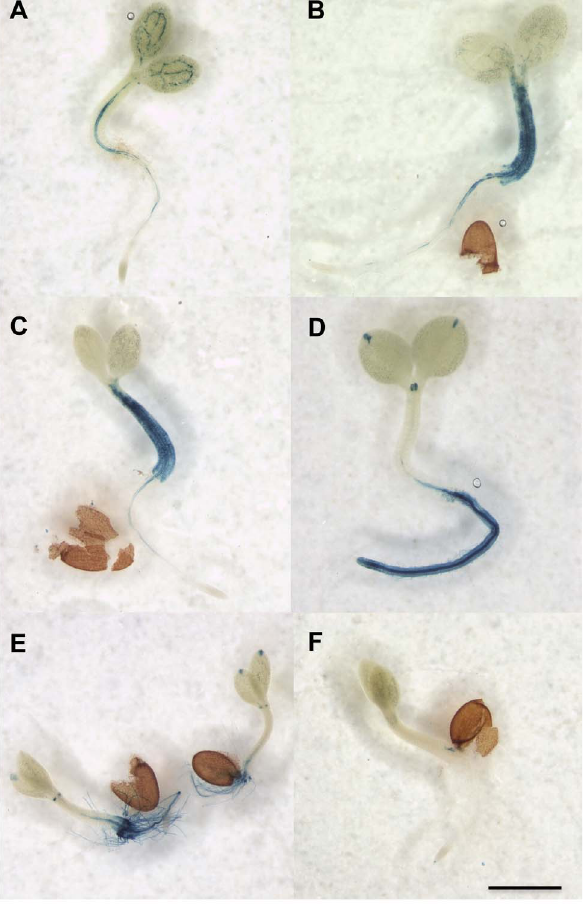
Figure 6. Transcriptional fusion analysis of Arabidopsis DEFL promoter constructs in T4 transgenic seedlings expressing pSCR: LhG4 / OP :GUS. Histochemical staining for GUS activity in 1- week-old seedlings transformed with promoter constructs of Arabi- dopsis DEFLs . A, At1g60989. B, At2g26020. C, At5g60553. D, At3g63360. E, At4g30074. F, At5g05598. Scale bar 10 m